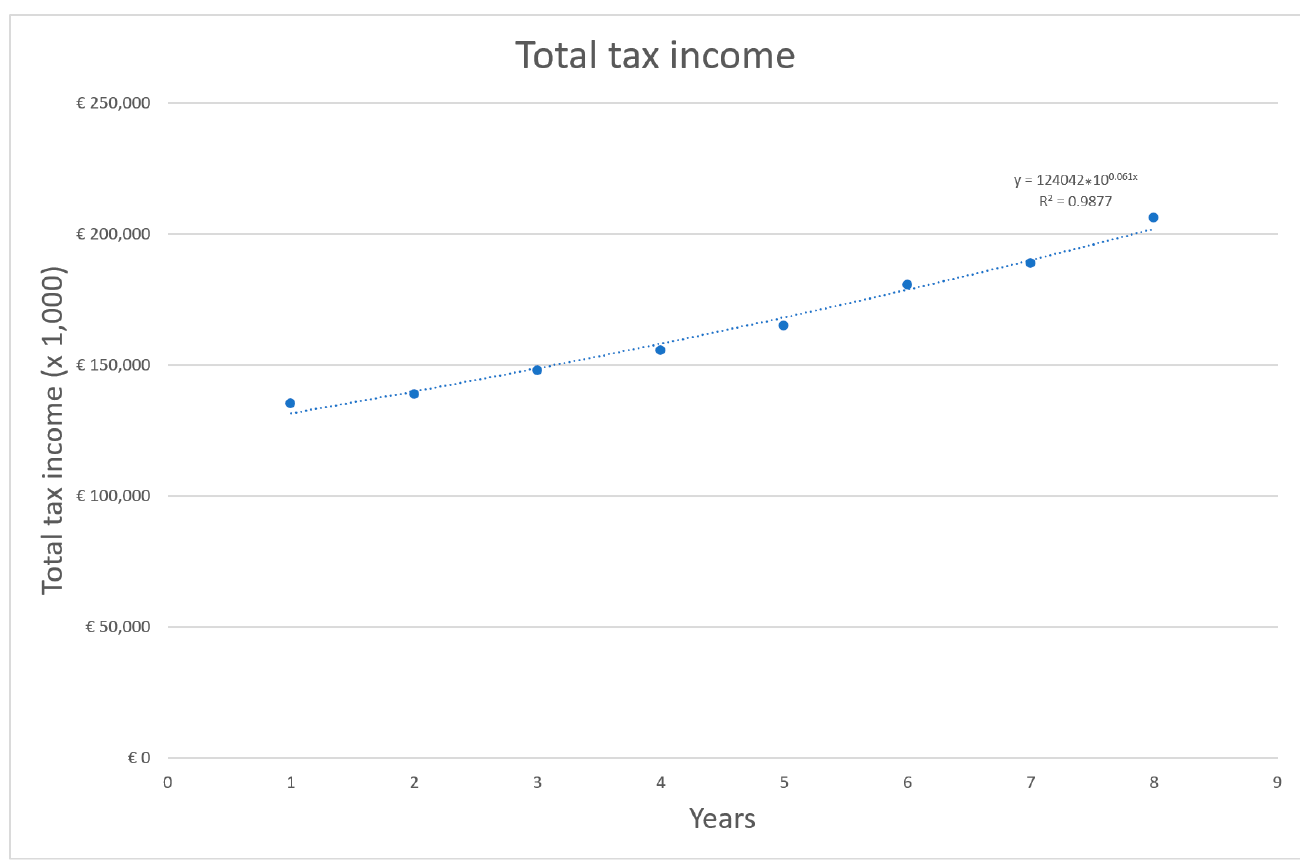
Figure 5. Total tax revenue over time between 2012 and 2019 [21].